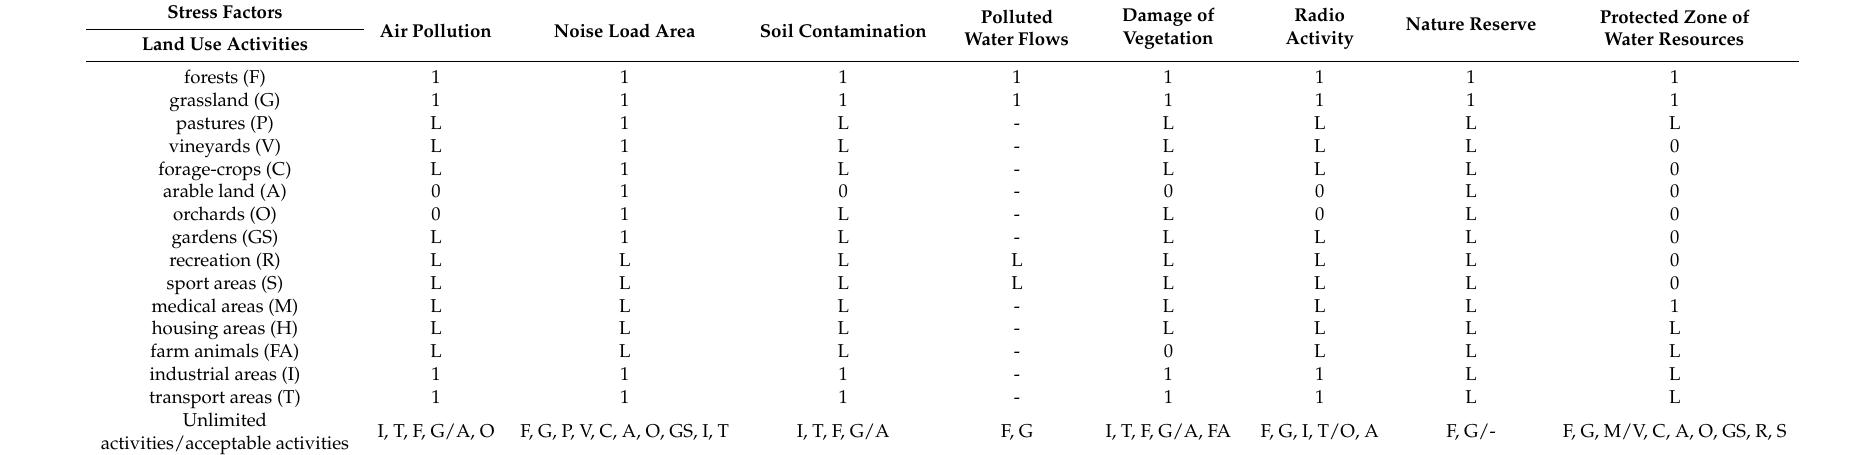
Table 1. Example of creation of environmental regulation based on environmental stress